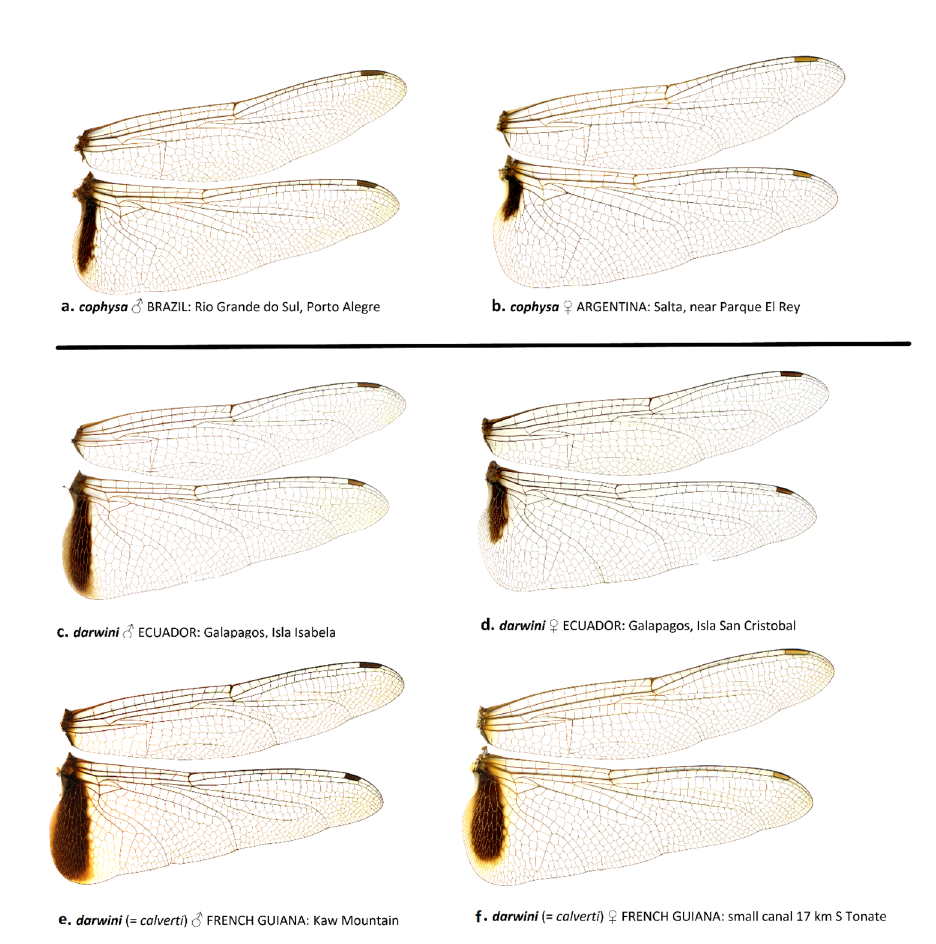
Figure 5. Wing scans of T. cophysa ( a , b ) and T. darwini (senior synonym of T. calverti , stat. rev.) ( c – f ). Coloration of the ventral abdominal tergites generally differs between T. cophysa and T. calverti . The majority of the ventral tergites in both sexes of T. cophysa are dark brown and of the same color as the lateral carinae in most of the abdominal segments (Figure 6a,b). The ventral tergites of some females (Figure 6c) may possess a lighter color differing from the dark lateral carinae but in those females, a light dusting of pruinosity is usually present on the more anterior segments (Figure 6c). The ventral tergites in T. calverti are always pale brown, with dark markings confined to the vicinity of the lateral carinae (Figure 6d–g). No pruinosity was observed in any of the T. calverti examined. Abdominal S8 is entirely dark brown in males of T. cophysa (Figure 7a,b), and the same is often observed in the females of this species (Figure 7c); but, in some females S8 shows a pale coloration confined to the lower half of the segment (Figure 7d). Both sexes of T. calverti consistently have an inverted pale brown semicircular spot at the base of S8 (Figure 7e,f), which is red or brown in live specimens. Specimens of Tramea from the Galapagos (Figure 7g,h) were consistent in coloration and pattern with T. calverti